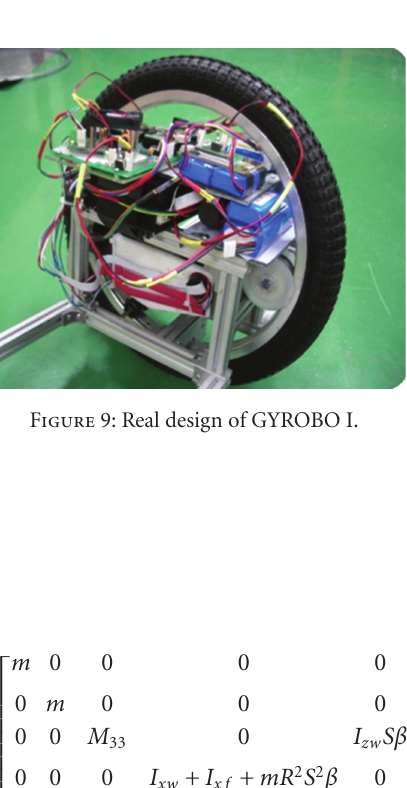
Figure 8: Models of GYROBO using gyro e ff ects.